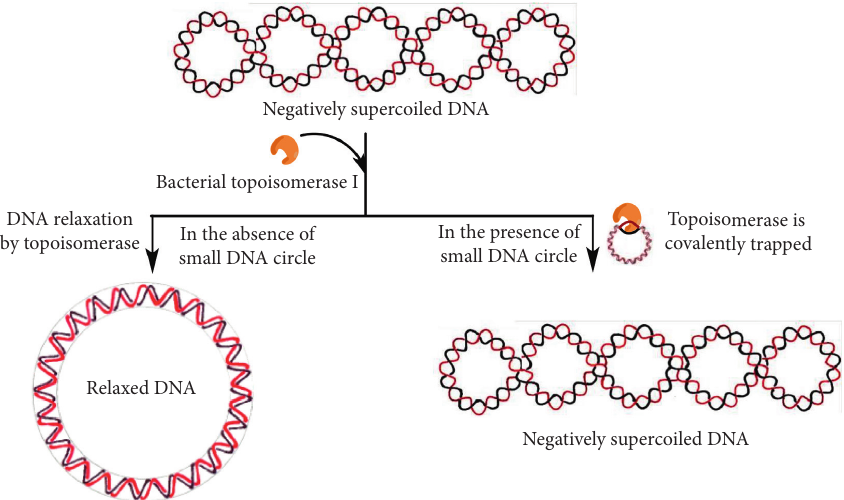
Figure 2: Illustration of the supercoiled plasmid relaxation catalyzed by bacterial topoisomerase I in the presence or absence of small DNA